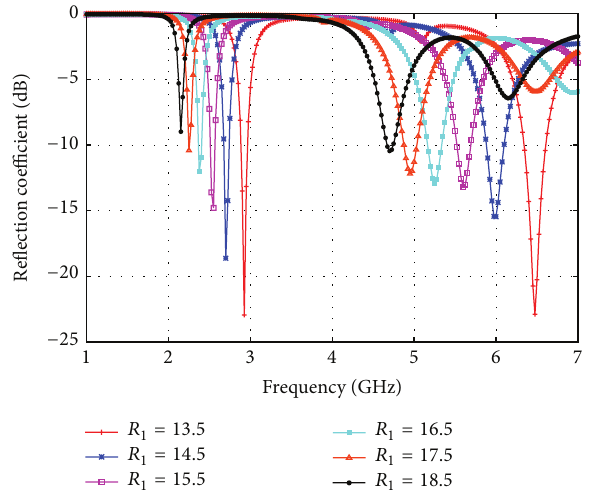
Figure 2: Simulations for different values of circular patch radius.